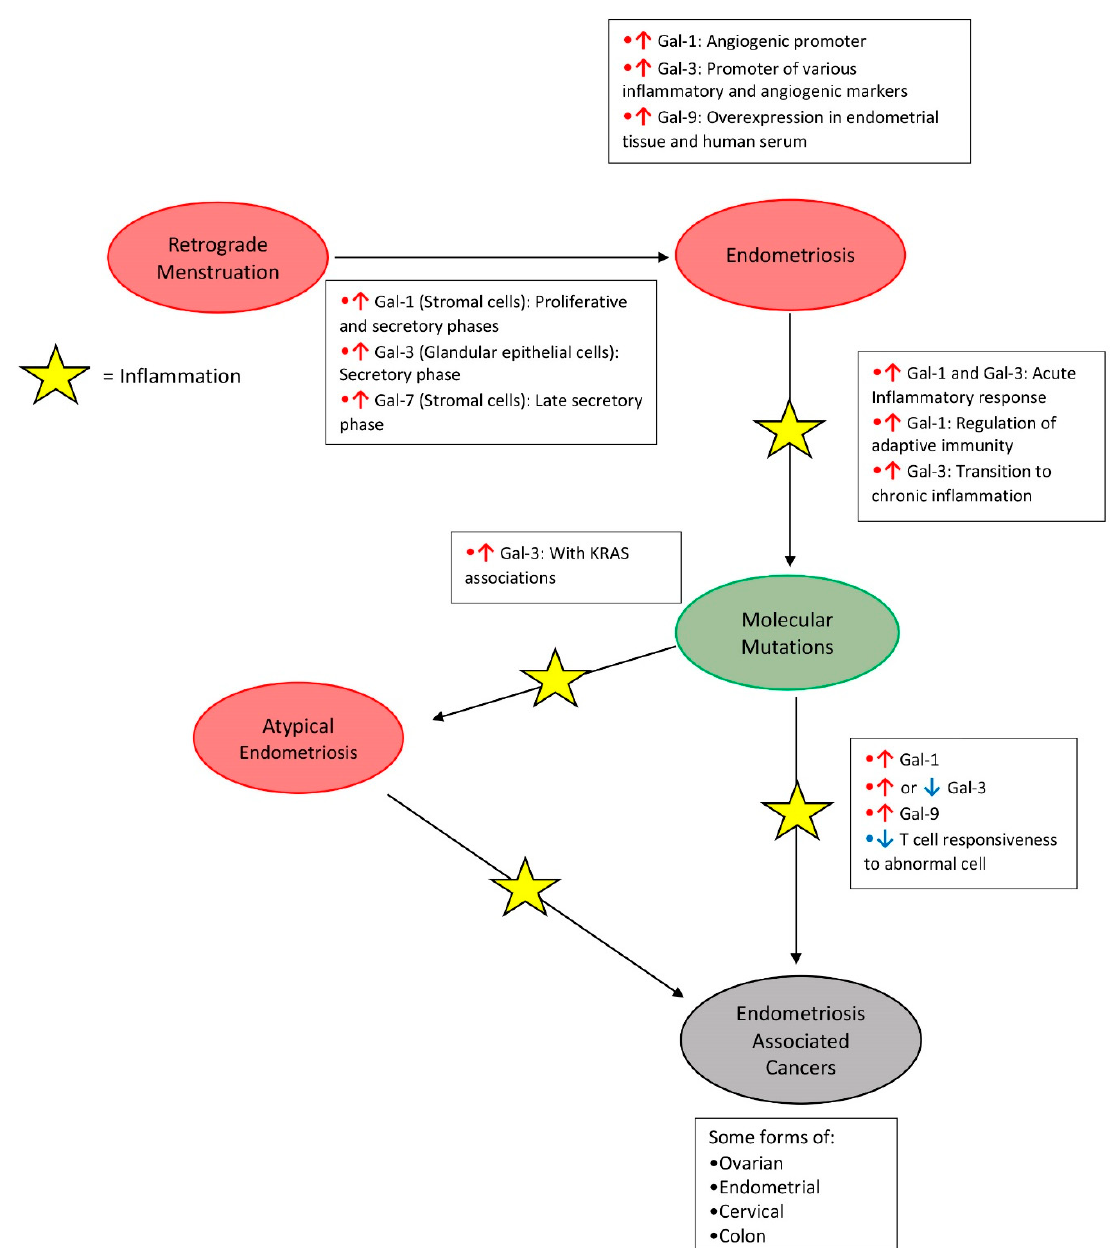
Figure 1. Modified model for potential development of endometriosis-associated cancers and changes occurring in the expression of human galectins. Red arrows indicate increased galectin expression, blue arrows indicate decreased galectin expression. Original model was proposed by Dawson et al. [40].